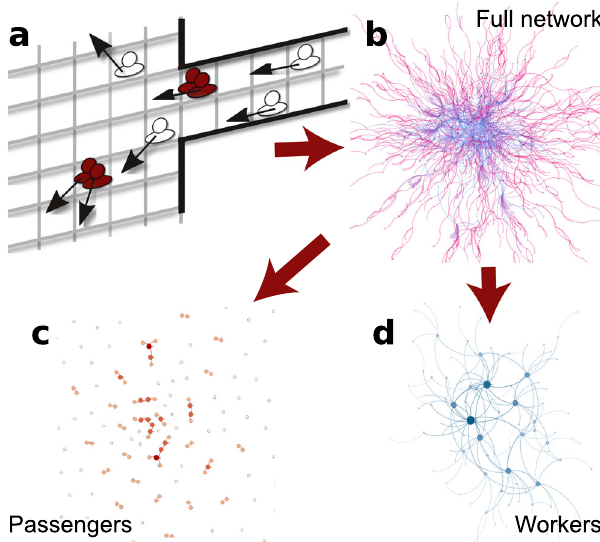
Fig. 1 | London Heathrow Airport aggregated copresence network of one- month data. a Sketch of the contact network construction: two individuals are linkediftheycoincideinacellwithinatimeslot. b Cumulativecopresencenetwork of 1 month. In blue the workers, in red the passengers. User type assortativity a i =0.45. c Travelers copresence network is a fragmented graph since there is an incoming and outgoing fl ow and they spend a relatively short period in the term- inals. d Workers copresence network is a connected graph: they interact recur- rently with each